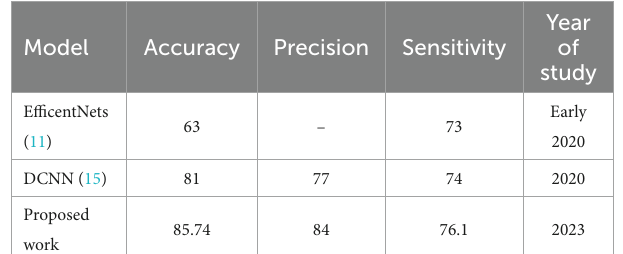
TABLE 8 Comparison with the recent related study.